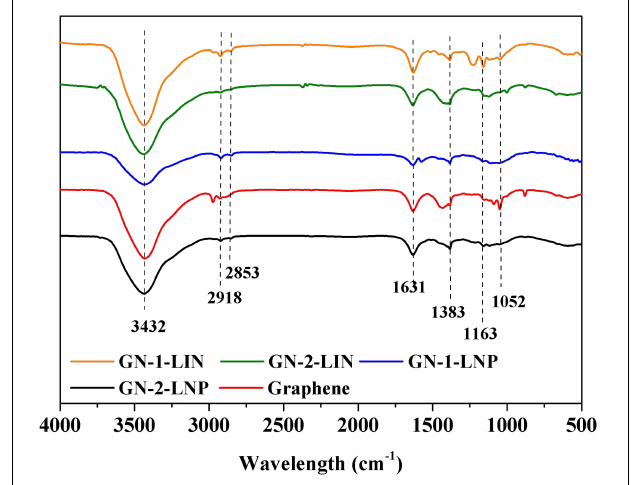
FIGURE 3 | FTIR spectra of the prepared carbons and commercial